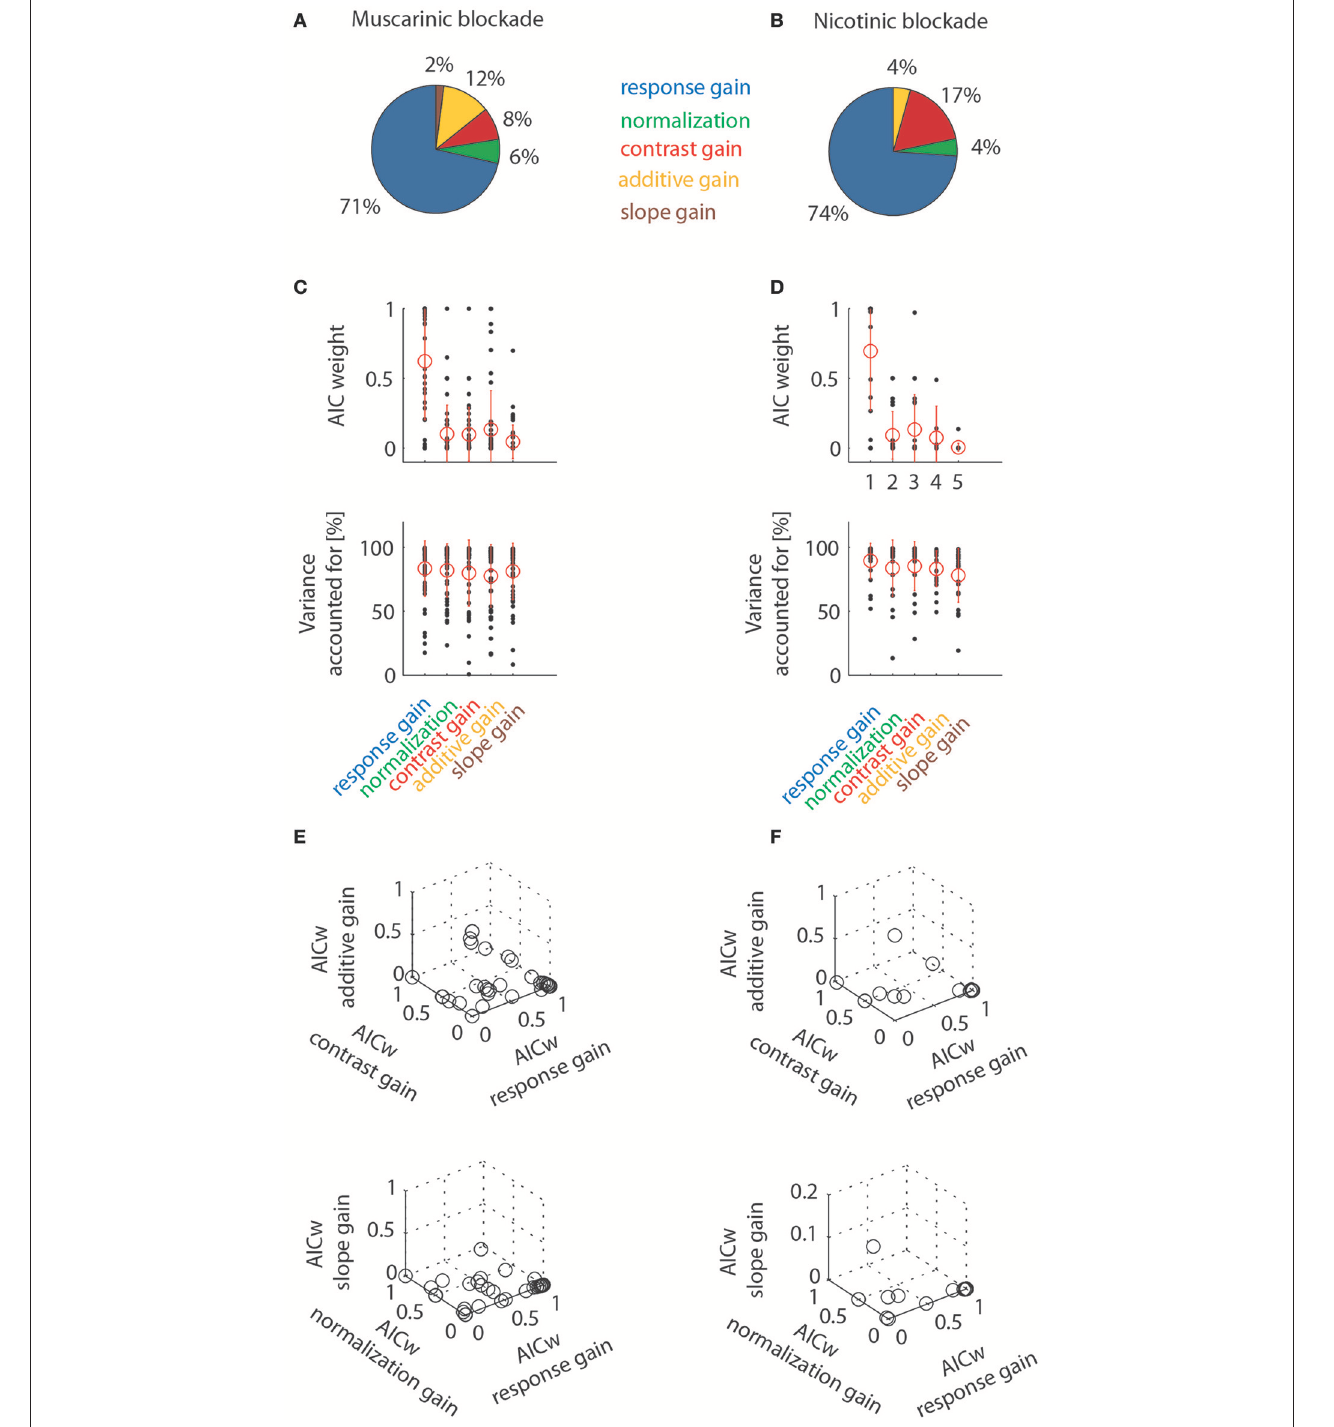
FIGURE 8 | Model comparison at the population level by means of Aikake information criterion weights (AICw) and variance accounted for. Left column shows data for cells tested with muscarinic blockade, right column shows data for cells tested with nicotinic blockade. Only cell significantly affected by drug application were taken into account. (A,B) Percentage of cells where drug effects were best fit by one of the models employed (quantified by taking the largest AIC weights). (C,D) Distribution of AIC weights and variance accounted for, given the different models. Red symbols denote means and standard deviation. (E,F) Triplet wise model comparison that shows how AIC weights are linked for individual cells. Most data points are clustered towards high values for response gain models (they are often overlayed on top of one another, which makes the crowding towards that location less apparent than really present).